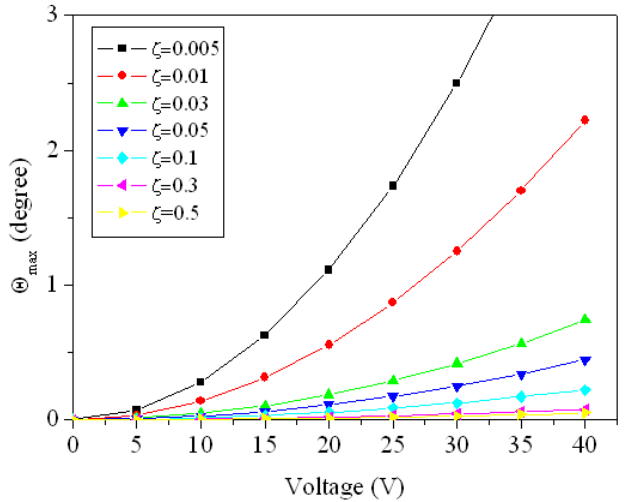
Figure 3. Maximum amplitude of the rotated angle in the micromirror at different damping